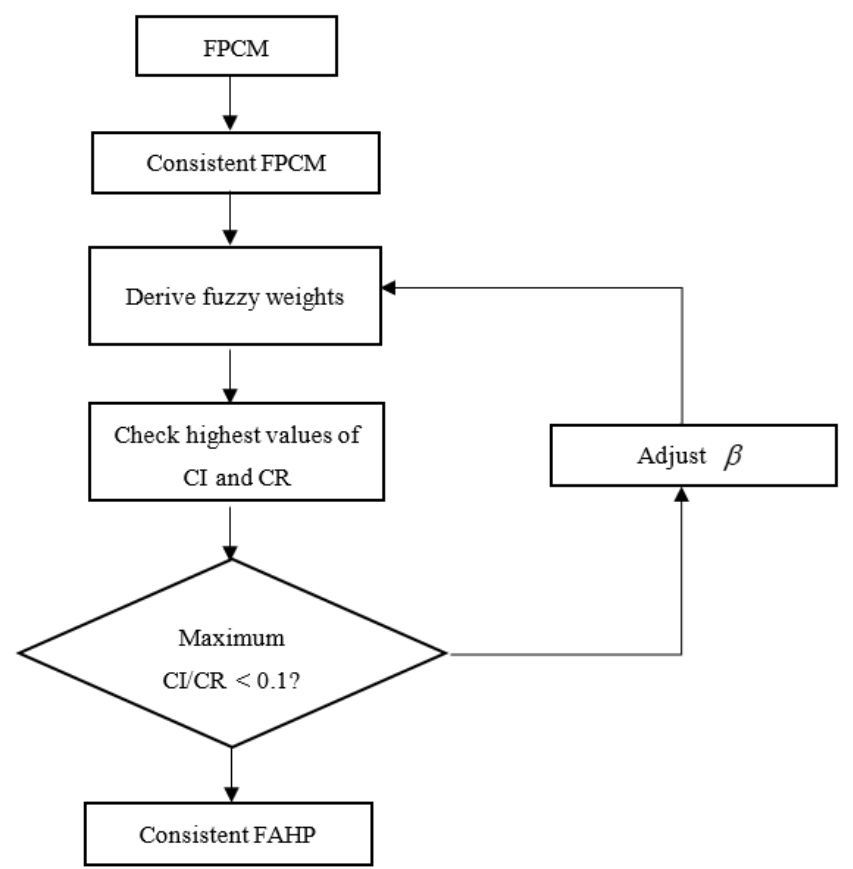
Figure 2. The flowchart of the proposed method.